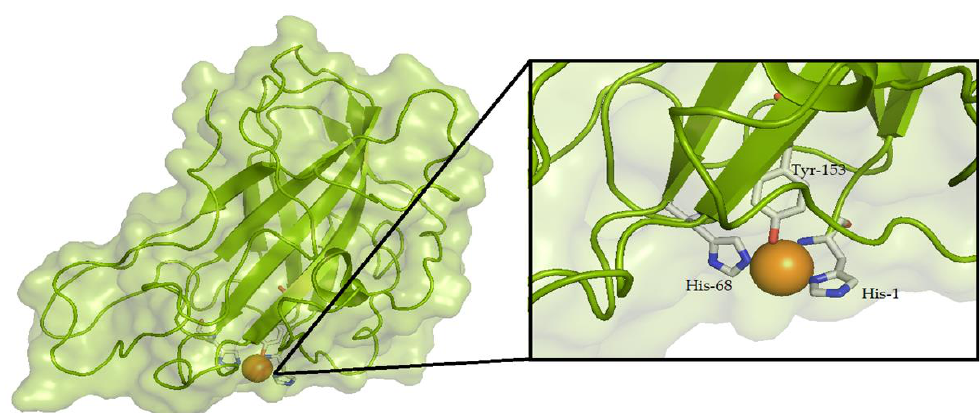
Figure 2. Crystal structure and catalytic center of a fungal LPMO. Schematic representation of the crystal structure and a close-up view of the histidine-brace of the cellulose-active Tt LPMO9E from Thielavia terrestris (UniProt ID G2RGE5, PDB 3EJA, strictly C1-oxidizing). The copper atom is shown as an orange sphere. The residues involved in the coordination of the copper are shown as sticks.